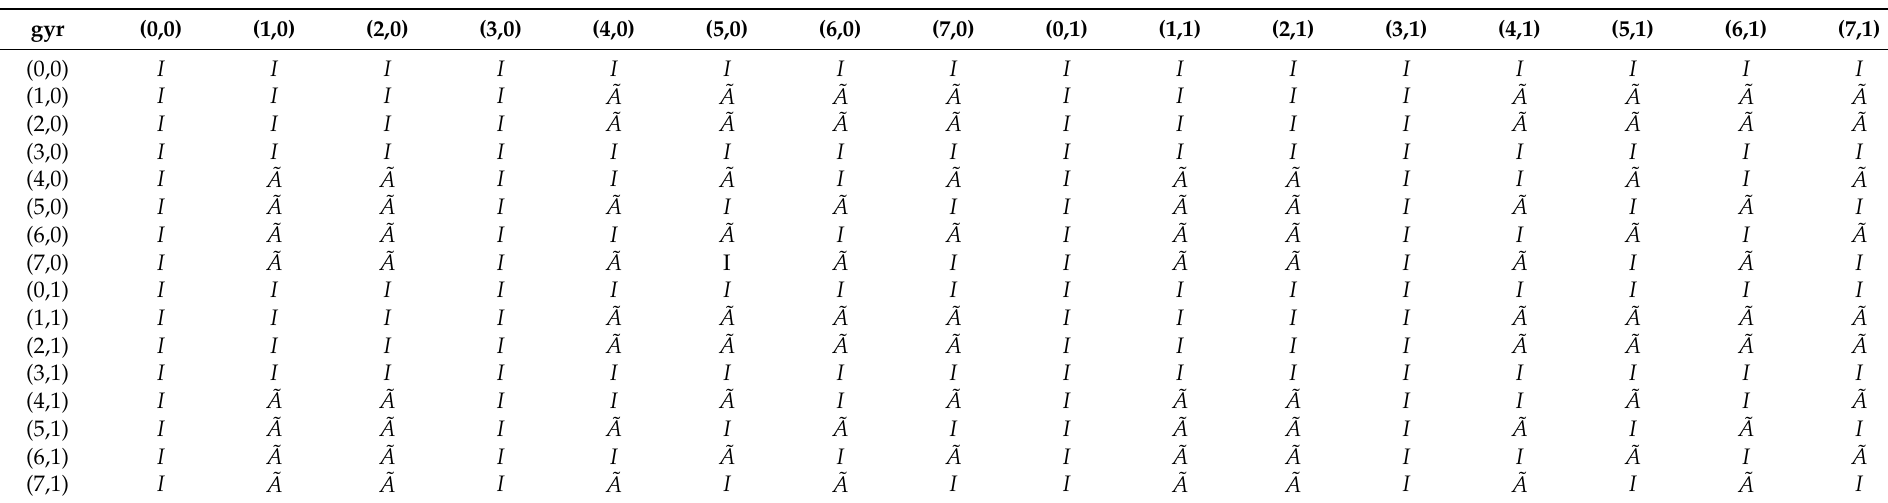
Table 3. The gyration table of the gyrogroup Dih ( G 8 ) . Here, I is the identity automorphism of Dih ( G 8 ) and ˜ A is given by Equation